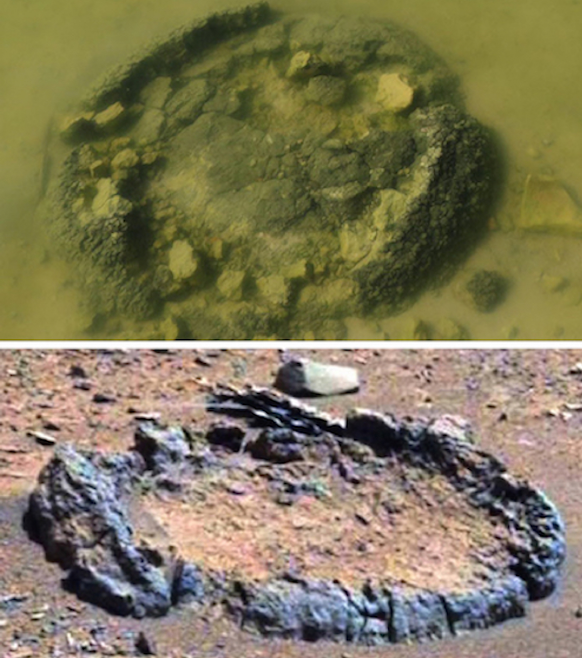
Figure 2. (Top): Lake Thetis stromatolites with collapsed domed (Photo credit: Lyn Lindfield And TheTravellingLindfields.com, re- produced with permission). (Bottom) Left: Sol 122. Sol 308. Pho- tographed in Gale Crater: Martian specimen with evidence of con- centric lamination and fossilized fenestrae. (From Joseph et al. 2020a, reproduced with